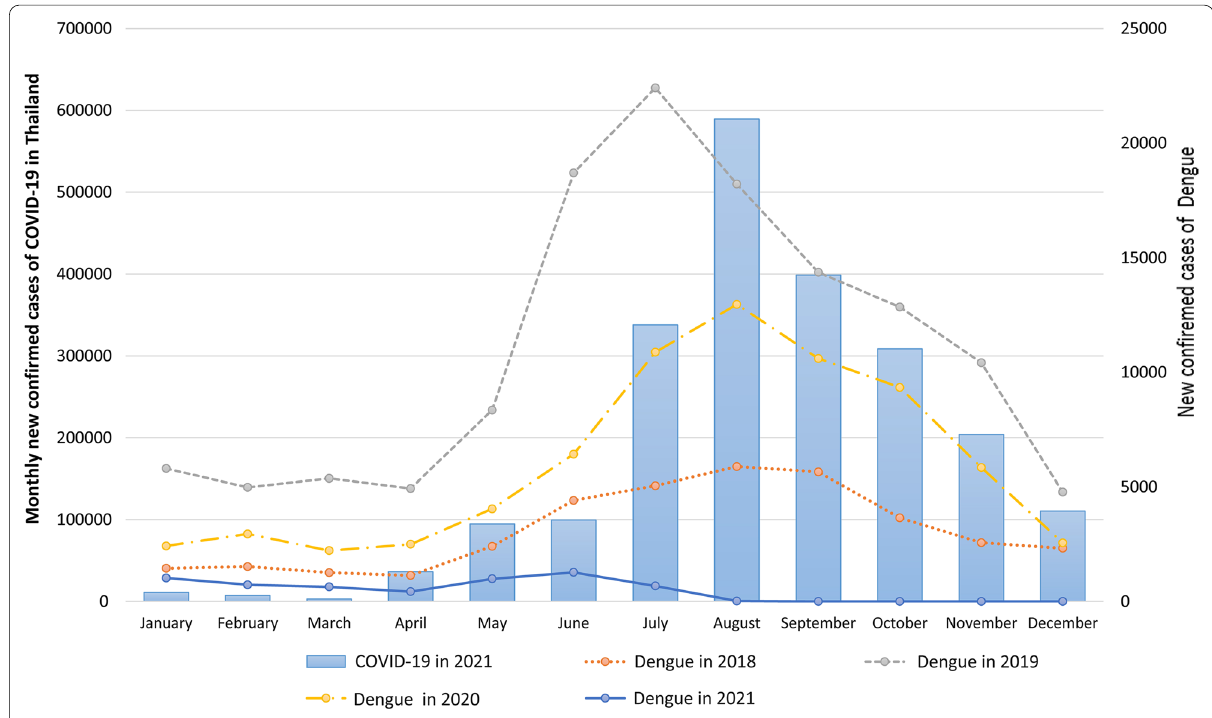
Fig. 3 Dengue cases from 2018 to 2021 in